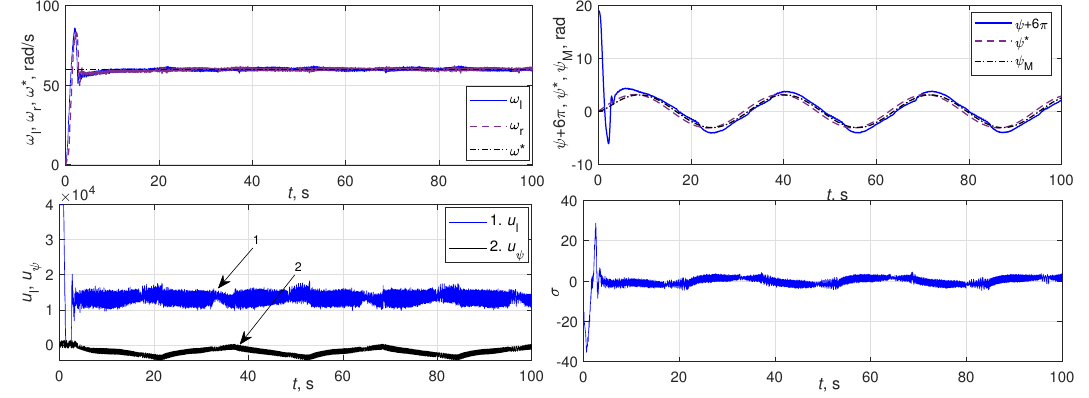
Figure 11. Experiment. Left column: ω l ( t ) , ω r ( t ) , ω ∗ ( t ) ( upper plot ) and control actions u l ( t ) , u ψ ( t ) ( lower plot ) time histories; right column: ψ ( t ) , ψ ∗ ( t ) , ψ M ( t ) ( upper plot ) and IMR discrepancy signal σ ( t ) ( lower plot ) for ψ ∗ = π sin ( 0.2 t ) . Sine-modification.